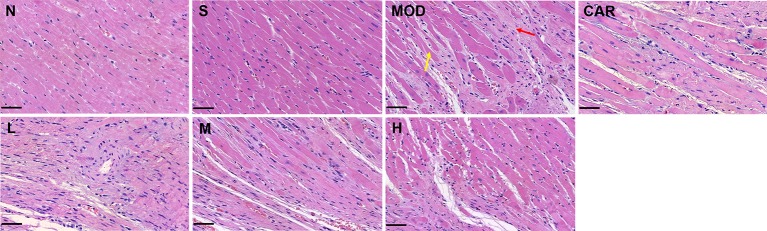
Photomicrographs of heart sections stained with hematoxylin–eosin in each group after coronary artery ligation (close to the coronary vein, 200×). Scale bar, 50 μm in each panel. The yellow arrow denotes damaged myocardial fibers, whereas the red one indicates inflammatory cell infiltration. N, normal; S, sham; MOD, model; CAR, carvedilol; L, 3 ml/kg Shenfu injection; M, 6 ml/kg Shenfu injection; H, 12 ml/kg Shenfu injection.